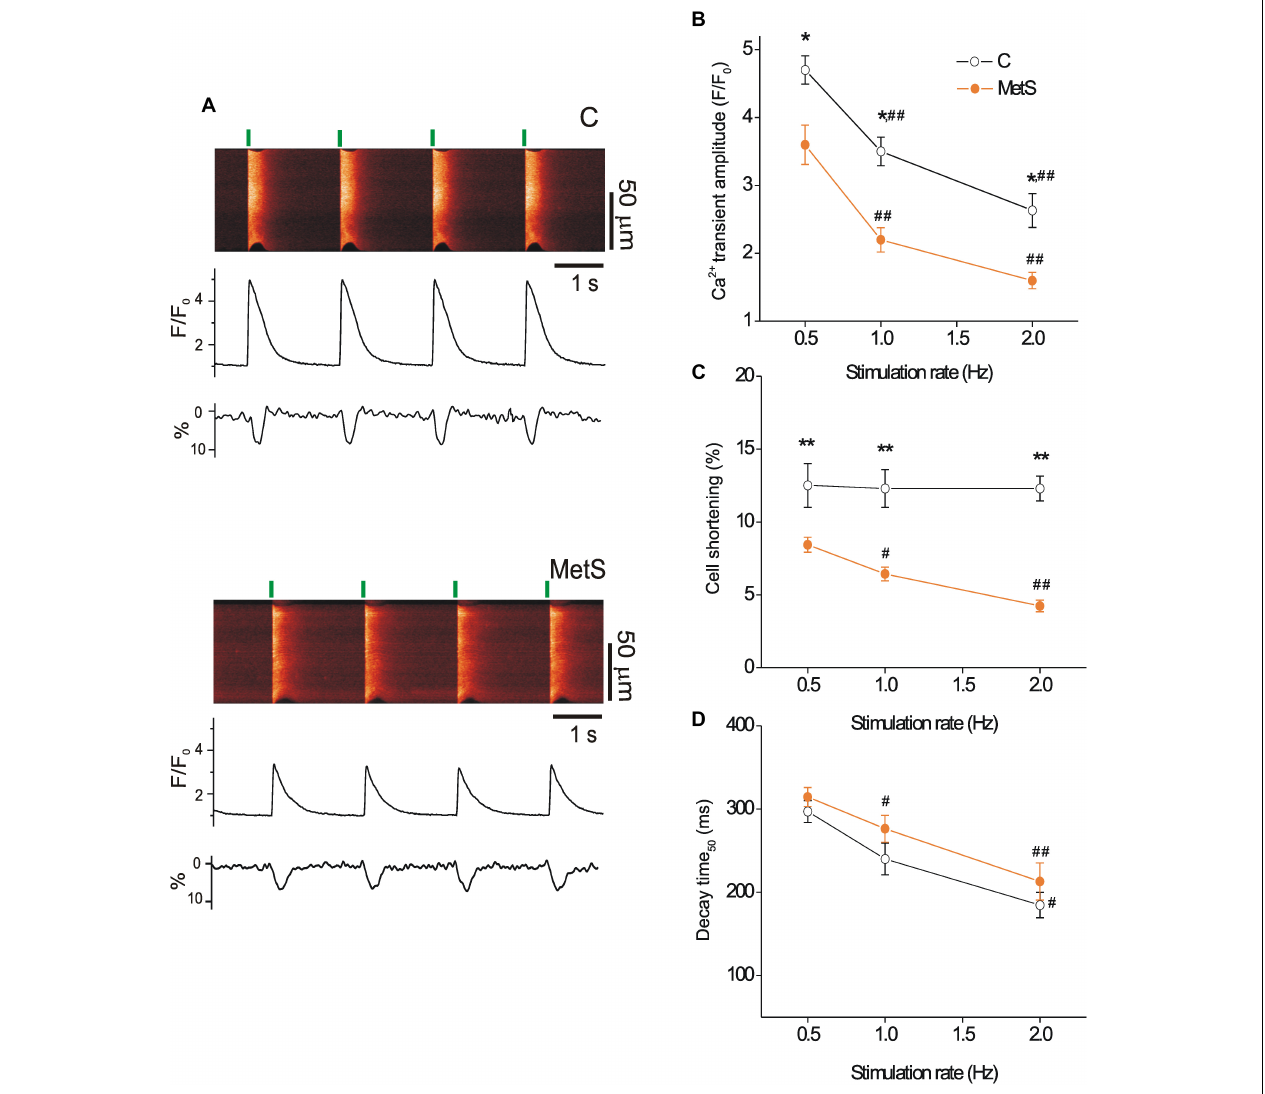
FIGURE 1 | Metabolic syndrome (MetS) cardiomyocytes exhibit a rate-dependent decrease in Ca 2 + transient amplitude and contraction. Representative line-scan images (A) recorded during electric stimulation (0.5 Hz) of Fluo 3-loaded ventricular myocytes isolated from control (C) and MetS rats. Green lines indicate the start of electric stimulation. The corresponding normalized fluorescence traces (F/F 0 ) and contraction profiles (in %) are shown below. (B) Average of Ca 2 + transient amplitude (expressed as F/F 0 , where F is the peak fluorescence signal and F 0 the diastolic fluorescence) of control ( open circles ) and MetS ( orange circles ) cardiomyocytes obtained by field stimulation at 0.5, 1, and 2 Hz. Average cell shortening (C) , and decay time at 50% of the normalized Ca 2 + transient (D) at 0.5, 1, and 2 Hz in n = 17 control cells vs. n = 32 MetS cardiomyocytes. ∗ P < 0.05, ∗∗ P < 0.001 respect to control cells. # P < 0.05, ## P < 0.001 respect to 0.5 Hz in the same